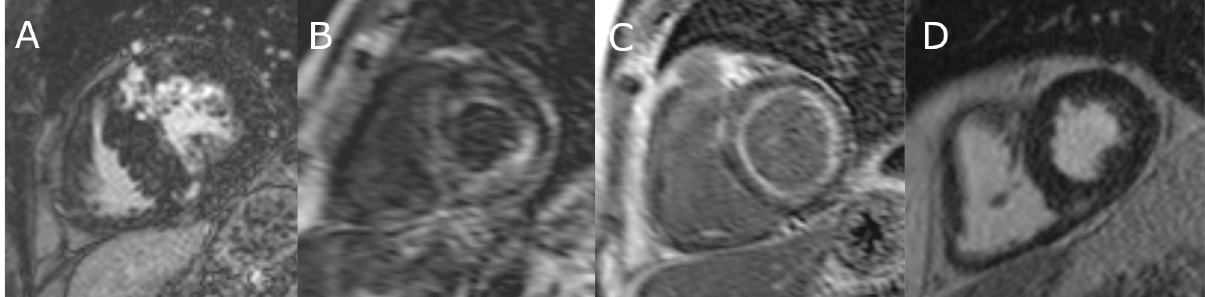
Fig 3. Representative late gadolinium enhancement images of patients with hypertrophic cardiomyopathy (A), cardiac AL-amyloidosis (B, C) and arterial hypertension (D) in a short-axis slice. A) Patchy mid-myocardial LGE in the hypertrophic segments typical for HCM (no diffuse subendocardial LGE, normal contrast kinetics). Myocardial nulling prior to blood pool nulling (B), and diffuse subendocardial LGE (C) typical for CA. D) Concentric hypertrophy without diffuse subendocardial LGE and with normal contrast kinetics in a patient with arterial